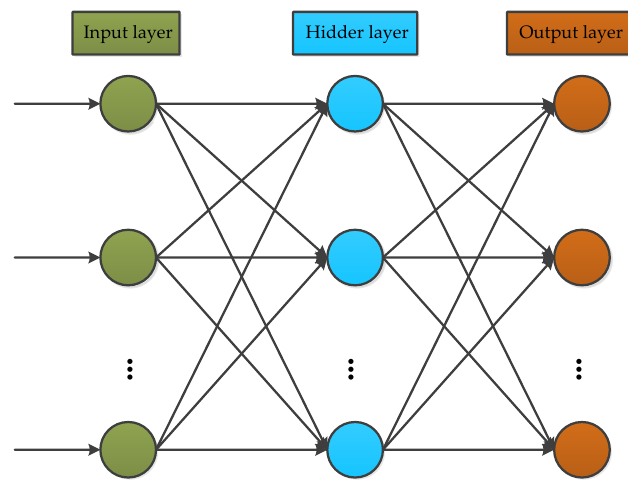
Figure 13. The classical architecture of Back propagation.